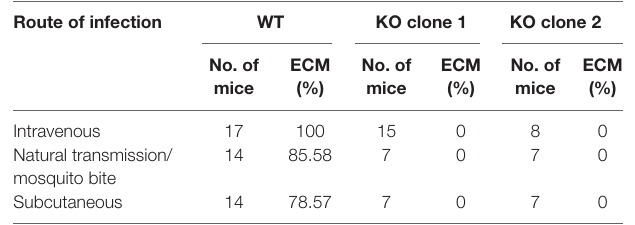
TaBle 2 | Mice infected with PbmaLS_05 ( − ) sporozoites do not develop experimental cerebral malaria (ECM).